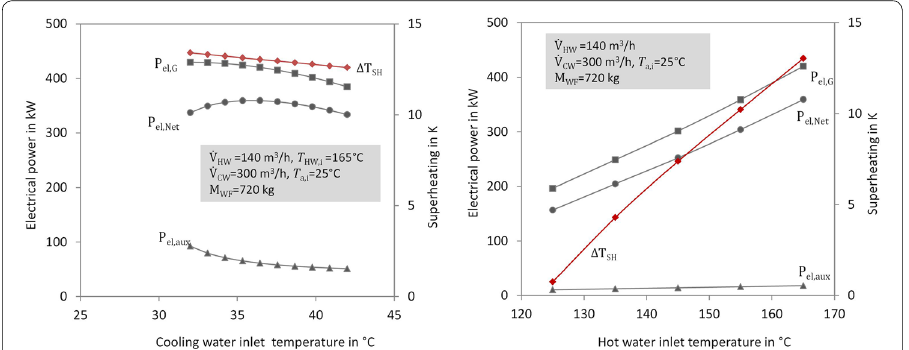
Fig. 17 Estimated generator power, net power, auxiliary power and superheating depending on the cooling water temperature (left) and the hot water temperature